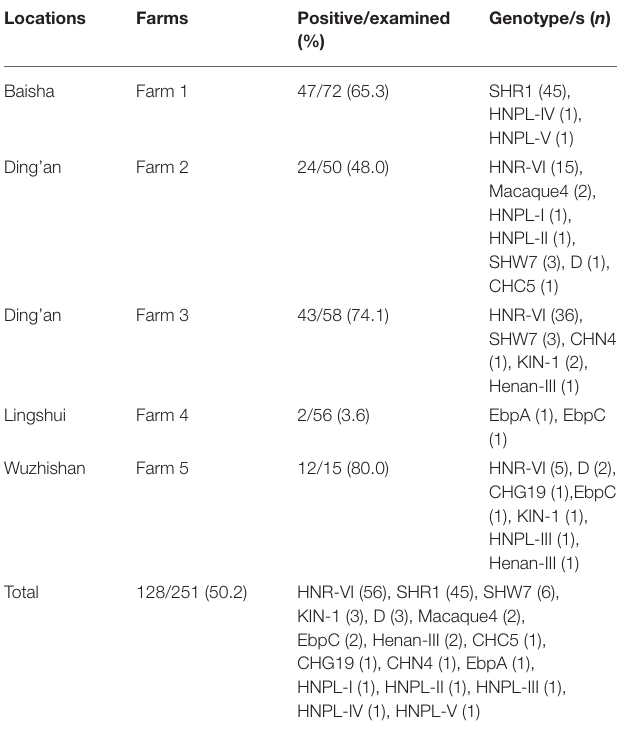
TABLE 1 | Prevalence and genotype distribution of Enterocytozoon bieneusi isolates in civets in Hainan Province.